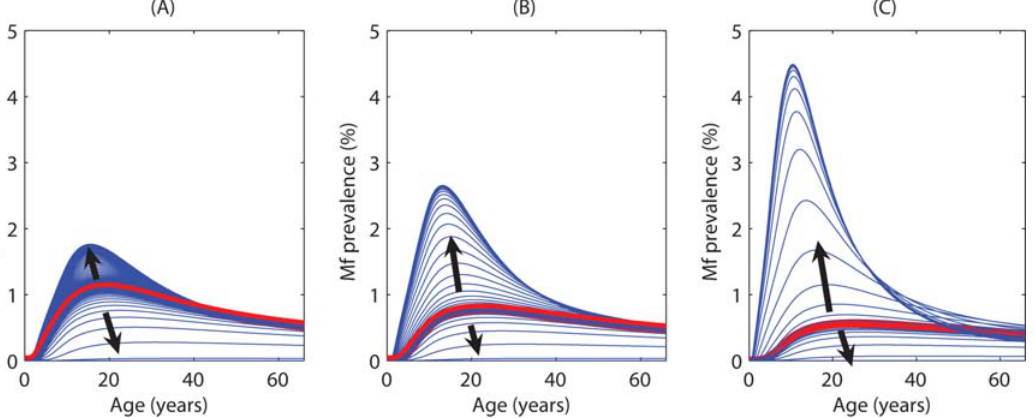
Figure 4. The direction of change of the Mf prevalence age-profile among human hosts at different anopheline vector biting rates. Results are shown for vector biting rates of (A) 280 (just above the TBR of 271), (B) 350, and (C) 600. In each case, the blue curves represent initial perturbations around the Mf age-profile corresponding to the breakpoint Mf prevalence (red curve), and the black arrows indicate the direction in which the curves are likely to travel on the way to attaining the zero or endemic stable equilibrium.